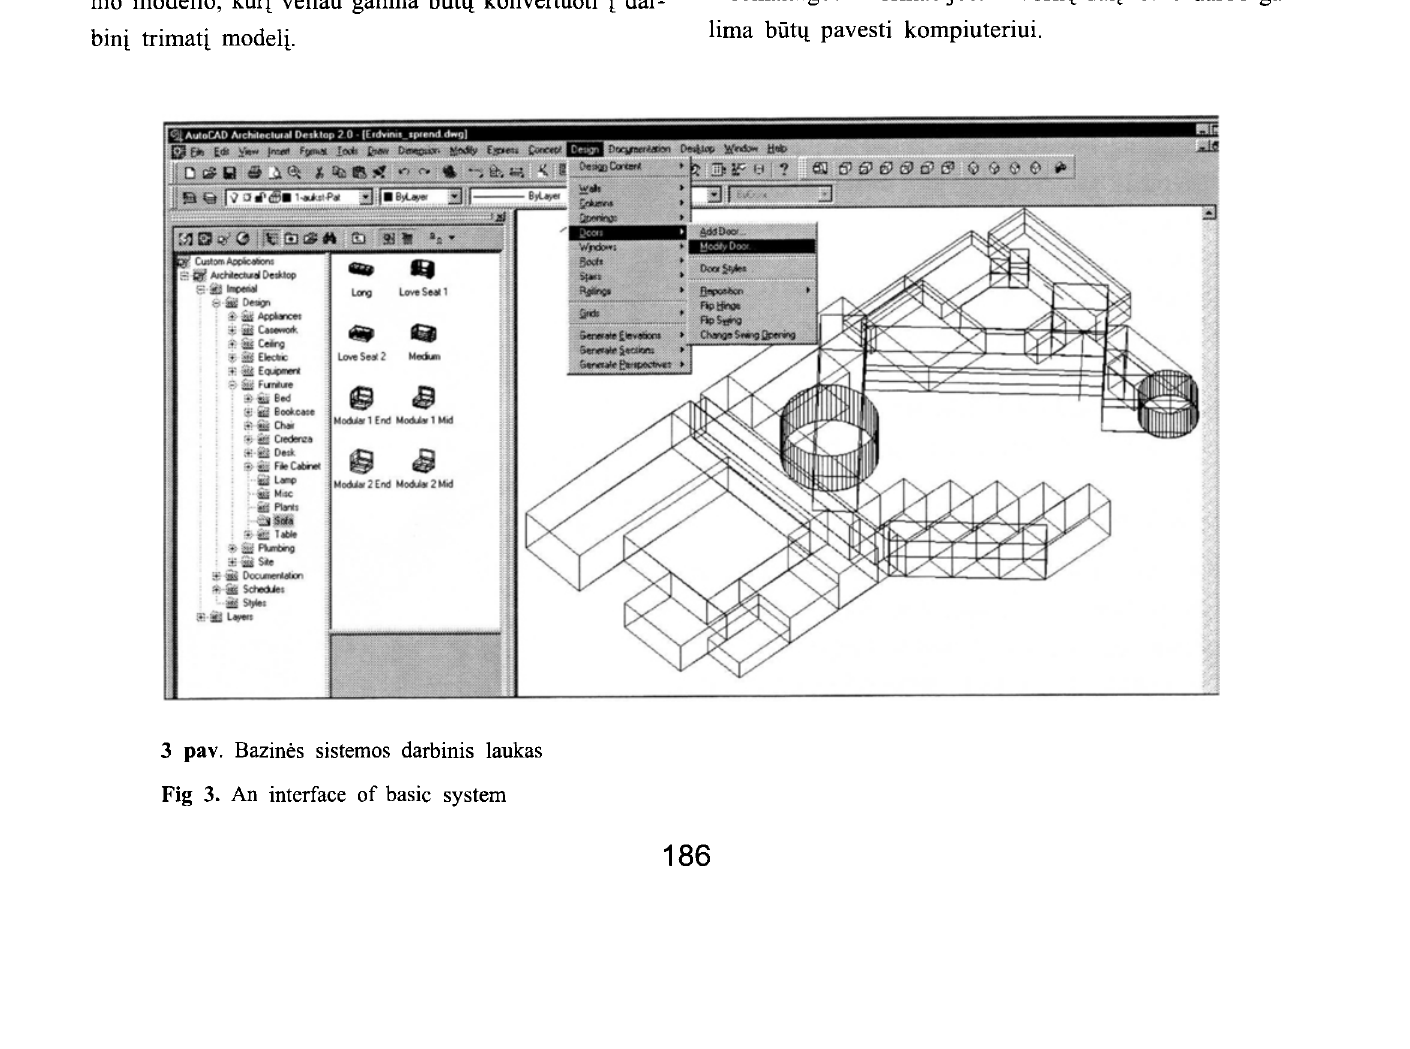
Fig 3. An interface of basic